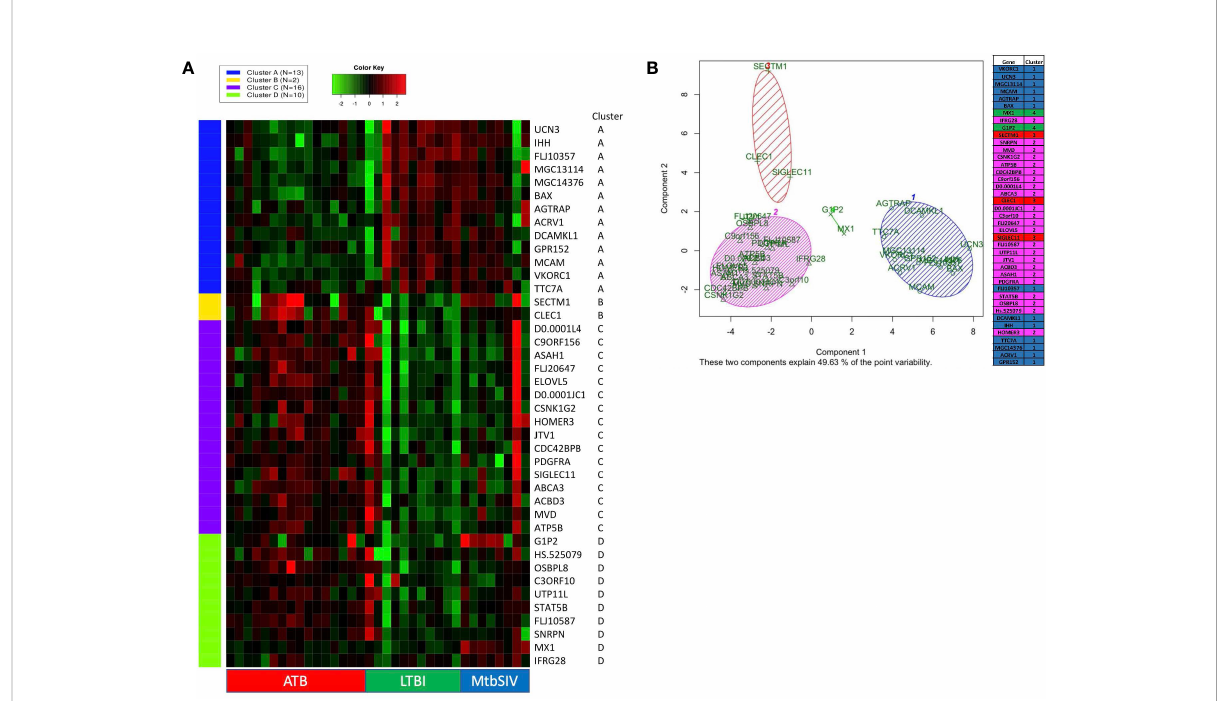
FIGURE 2 K-means clustering and Principal Component Analysis on 41 GOIs. (A) Using iDEP, k-means clustering was performed to identify different clusters in our 41 GOI dataset. The four clusters which were formed (Clusters A-D) are denoted by different colors (Cluster A – Blue, Cluster B – Yellow, Cluster C – Purple, and Cluster D – Green). The gene-expression is denoted by a green-red heatmap with a color key of Green = lower fold=change or repression and Red = higher fold-change or induction, relative to baseline. The key on the right shows Of fi cial Gene Symbols, while the key at the bottom shows different samples. Using Graphpad Prism 8, we created a heatmap of 41 genes and animals, with a range of 1e-008 to 6 (red), 0 (black), and -5 to 1e-008 (green) Some RM did not have recorded expression of a particular gene, denoted as white. Out of range values (magenta) were primarily found in LTBI and ATB cohorts, in which values were much lower than the given boundaries of the downregulated gene expression. (B) Using R PCA was performed across all cohorts to cluster the 41 genes. A set number of clusters, 4, was